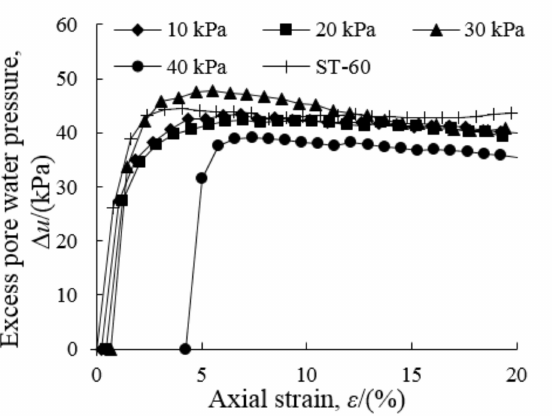
Figure 10. Variations of excess pore water pressure versus axial strain of the soft soil at various cyclic stress ratios after cyclic loading ( n = 1000, p (cid:48) 0 = 60 kPa, U r = 100%).